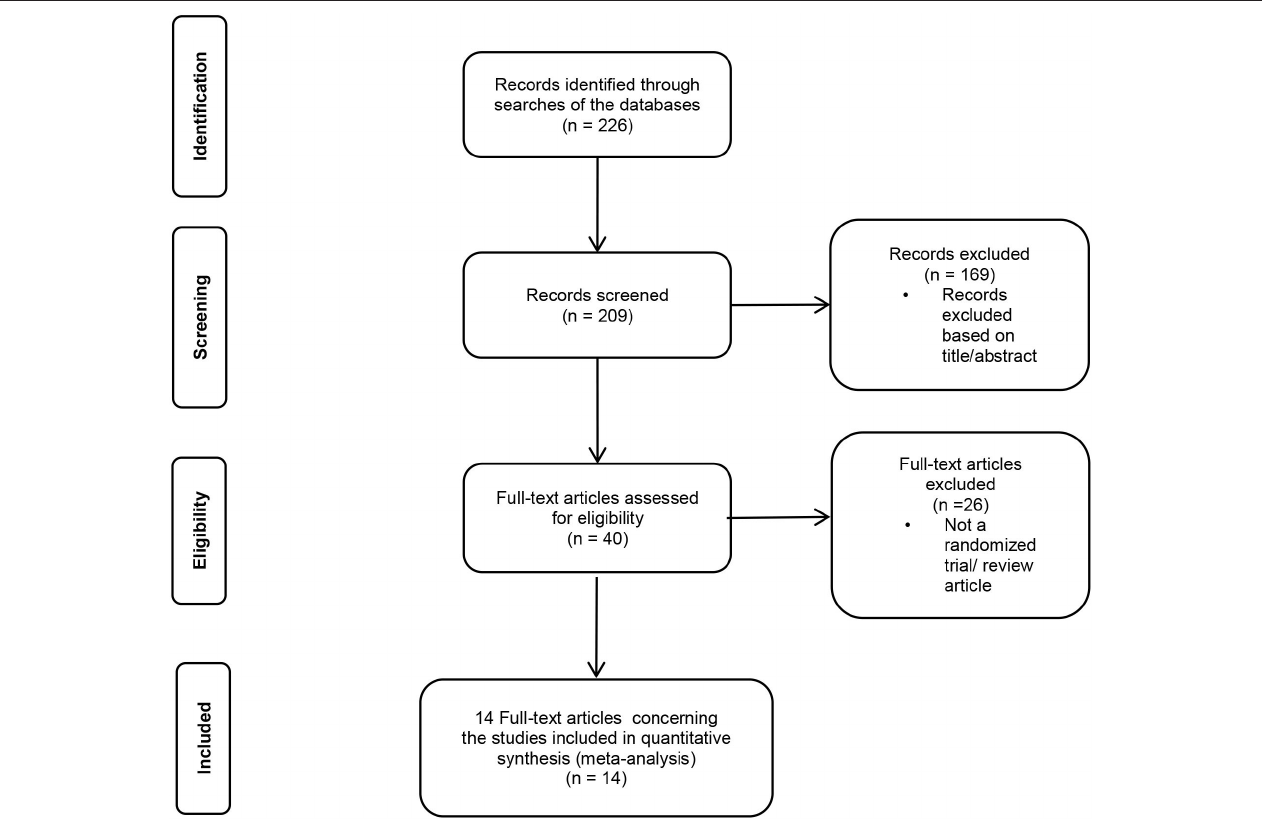
FIGURE 1 | Preferred reporting items for meta-analysis (PRISMA) flow diagram of literature